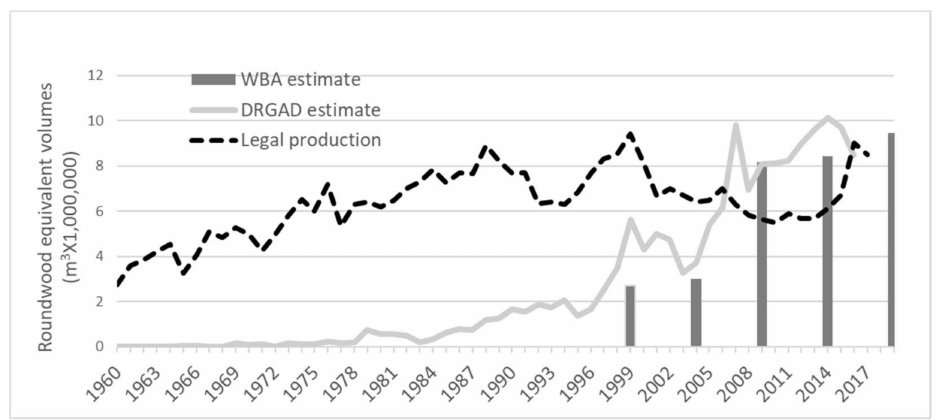
Figure 2. Estimated trends of illegal logging compared to timber